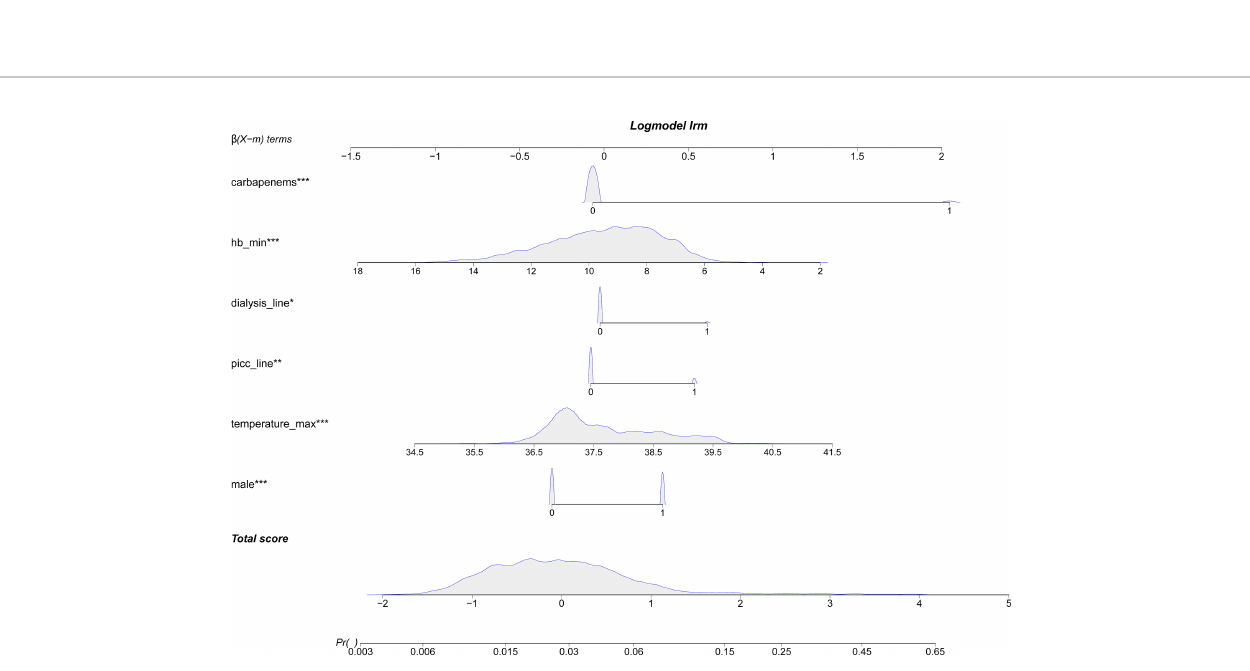
FIGURE 4 | Decision curve analysis (DCA) of the prediction models based on the training and validation set (A) . Calibration curves were constructed in the training and validation (B) set. The ROC curve of the prediction models is based on training (C) or validation (D) set.